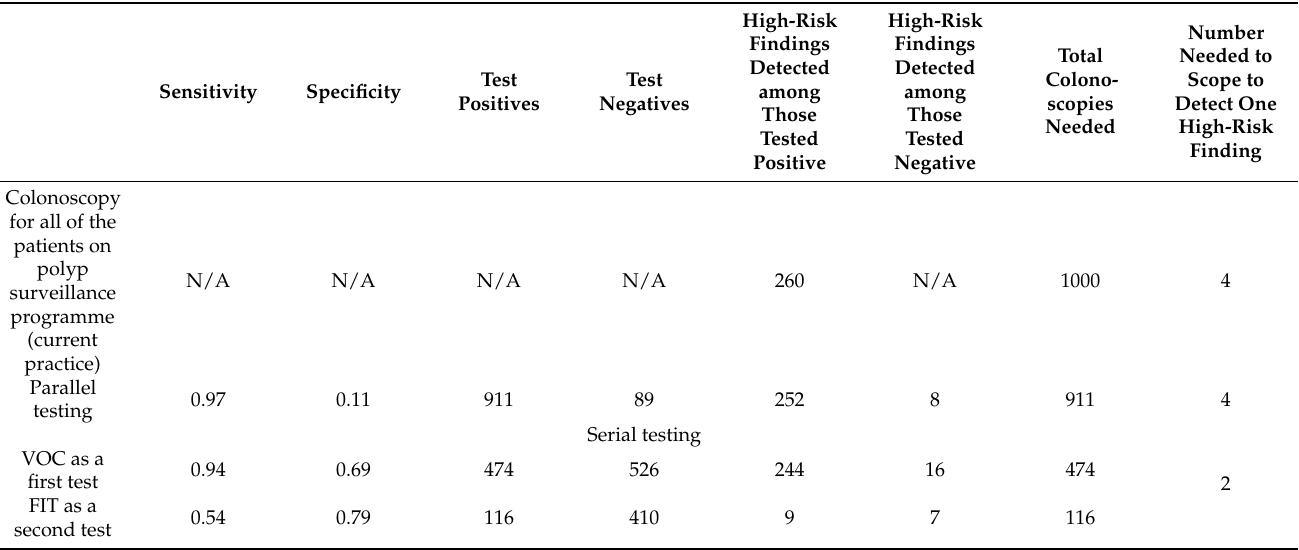
Table 4. Comparison of parallel and serial testing scenarios per 1000 polyp surveillance patients. Prevalence = 26% =